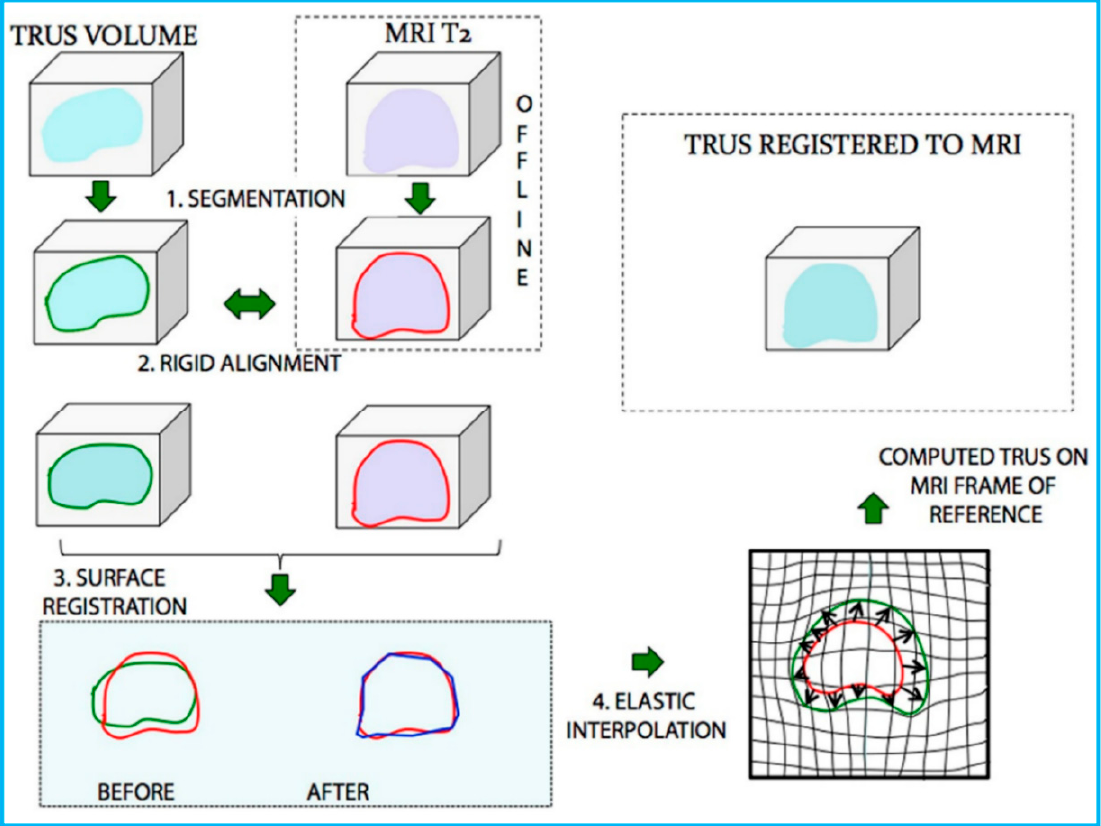
Figure 9. Schematic illustration of the process of US/MRI fusion. MR and transrectal US (TRUS) images were (1) segmented and then (2) rigidly aligned. Fusion then proceeded, involving (3) a surface registration, and (4) elastic (non-rigid) interpolation. Reprinted from [135] with permission.